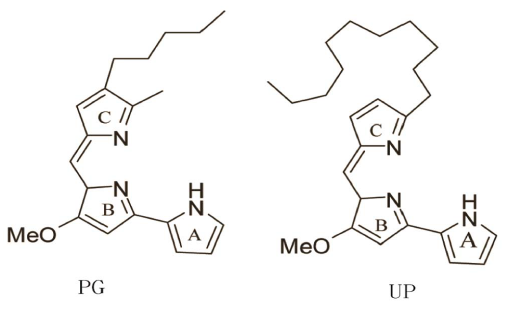
Figure 1. Structures of prodigiosin (PG) and Undecylprodigio- sin (UP).